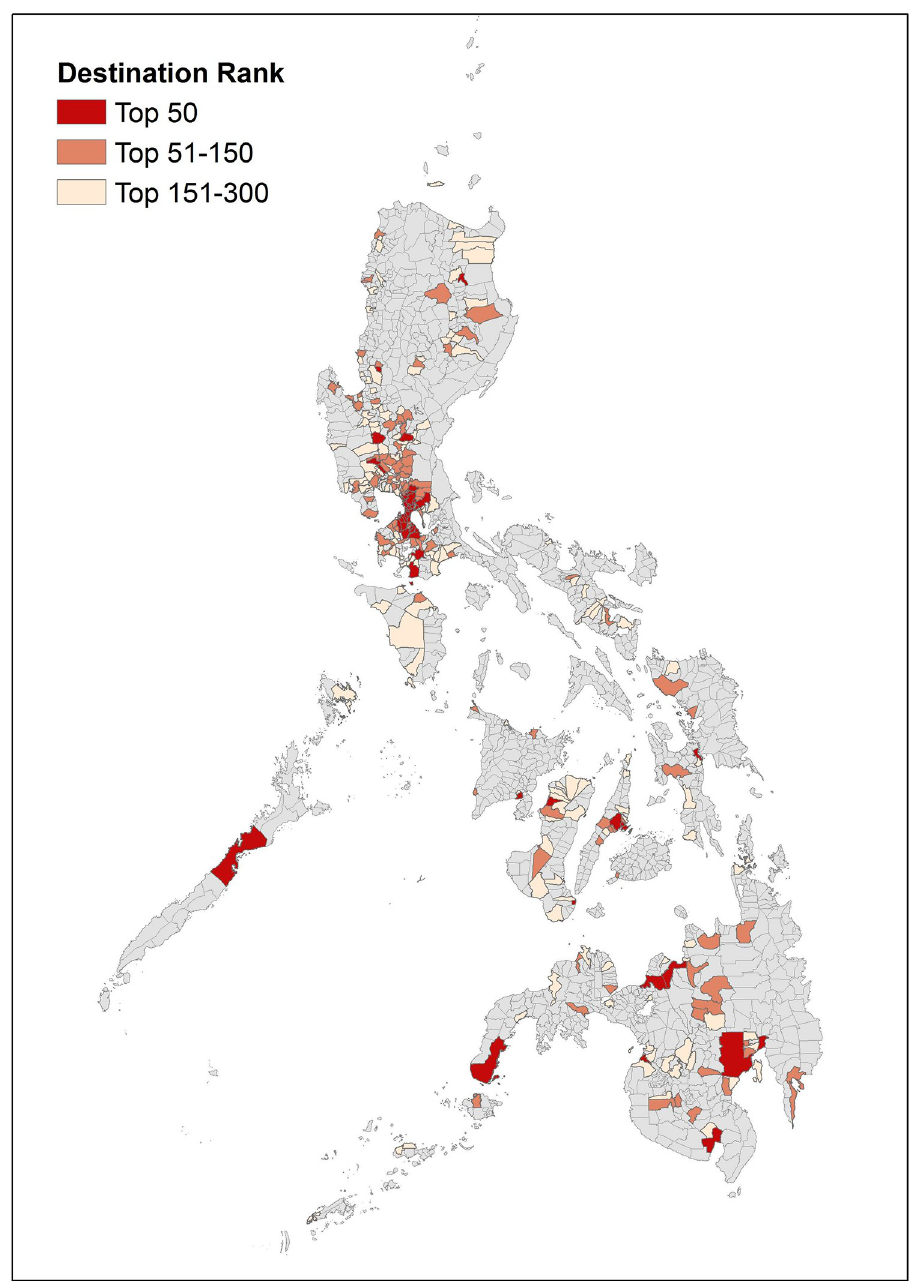
Fig 1. Top 300 morning destination cities and municipalities. Source: Philippine municipality shapefile created by the Philippine Statistics Authority (PSA)in the context of the 2015 population census was retrieved from https://data. humdata.org/dataset/cod-ab-phl. Note: Cities and municipalities are ranked based on the sum of inflows between 4 am and 10 am averaged over weekdays from January 2 to March 13, 2020.